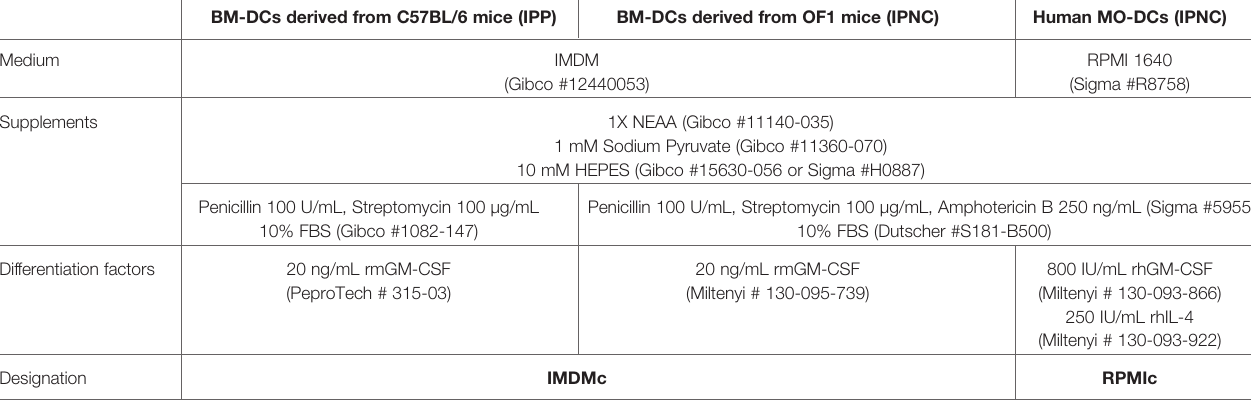
TABLE 2 | Cell culture media used for DCs differentiation and activation at the Institut Pasteur in Paris (IPP) and Institut Pasteur of New Caledonia (IPNC). BM-DCs derived from C57BL/6 mice